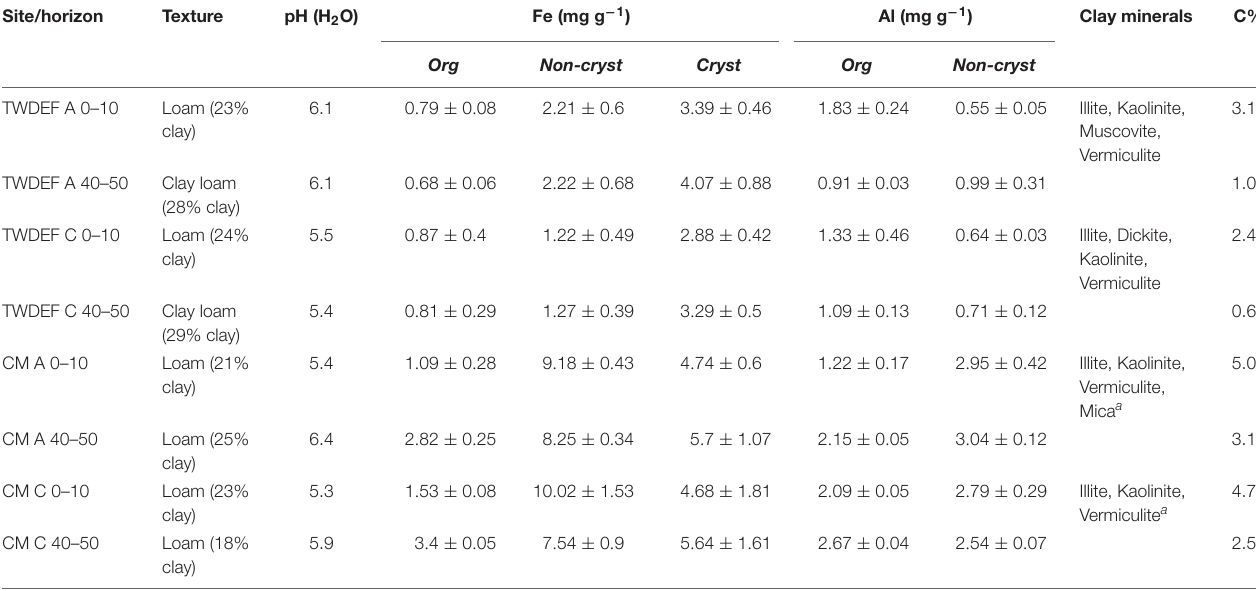
TABLE 1 | Selected soil properties from TWDEF and CM study sites. Site/horizon